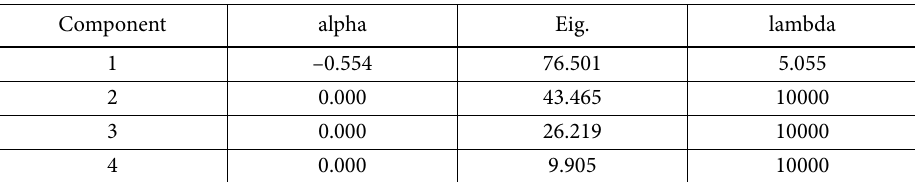
Table 6. Posterior estimates of principal components of explanatory variables in case of Czech Republic (source: own results)